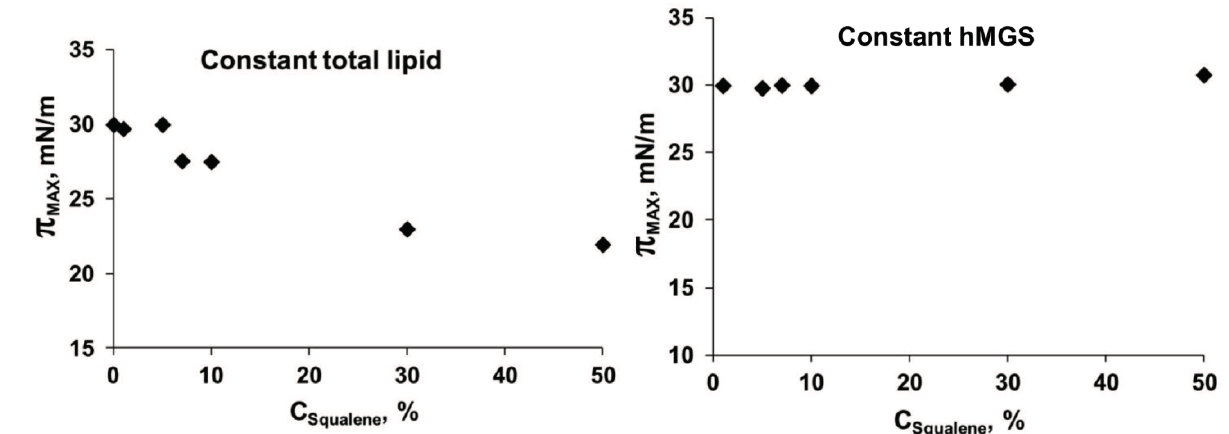
Figure 6. Dependence of the maximal surface pressure of mixed hMGS/SQ films on the concentration of squalene (in weight %). Left panel shows the dependence when the amount of total lipid (=hMGS + SQ) on the surface is kept constant and the hMGS/SQ ratio is varied within this fixed total lipid quantity; and Right panel shows the dependence when the hMGS amount is kept constant, and the addition of SQ increases the total lipid amount on the surface. The π max value depends on the “end members” of the surface film. If, at the end of compression, the interface between the lipid multilayer and the aqueous subphase is enriched with molecules with surfactant properties (e.g., polar lipids) the π max value is high. If, at the end of compression, the interface between the lipid multilayer and the aqueous subphase is poor on molecules with surfactant properties (e.g., polar lipids) the π max value decreases. When the amount of hMGS was kept constant, the following features were observed: (i) the course of the π (A)-compression isotherms of the different hMGS/SQ layers tended to approach each other and at surface pressures π ≥ 15mN/m the π (A)-isotherms of films containing 1%–30% SQ almost overlapped and (ii) the maximal surface pressures (Figure 6, right panel) achieved at the end of compression by the pure hMGS films and the hMGS/SQ mixtures practically